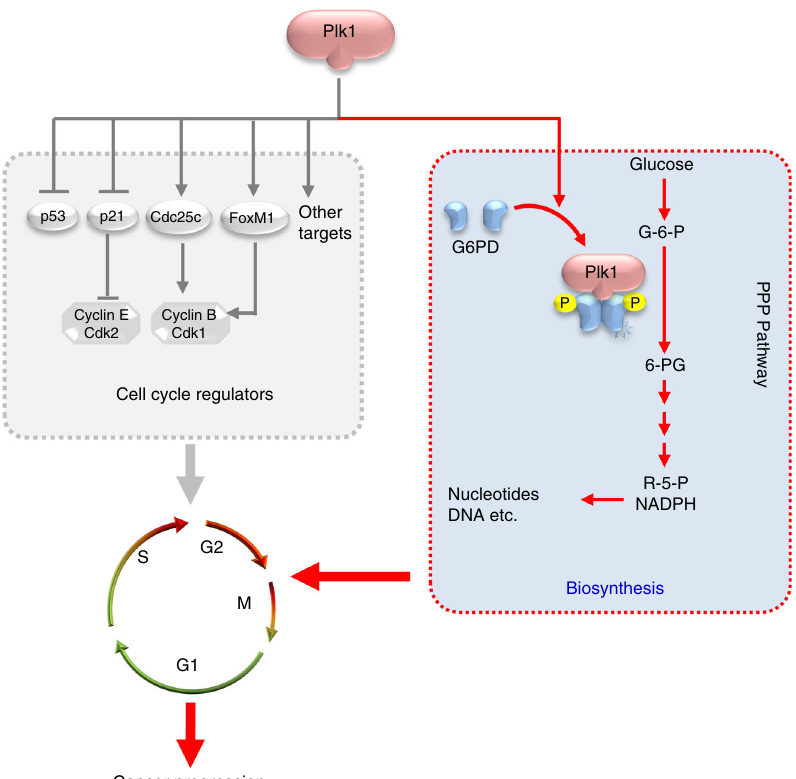
Fig. 8 Working model. In this study, we demonstrate that Plk1 interacts with and directly phosphorylates G6PD to promote the formation of its active dimer, thereby enhancing PPP fl ux and macromolecule biosynthesis. Together with previous reports that have established multiple critical roles for Plk1 in regulation of mitosis and cell cycle progression, we propose that Plk1 coordinates biosynthesis with cell cycle progression to promote cancer